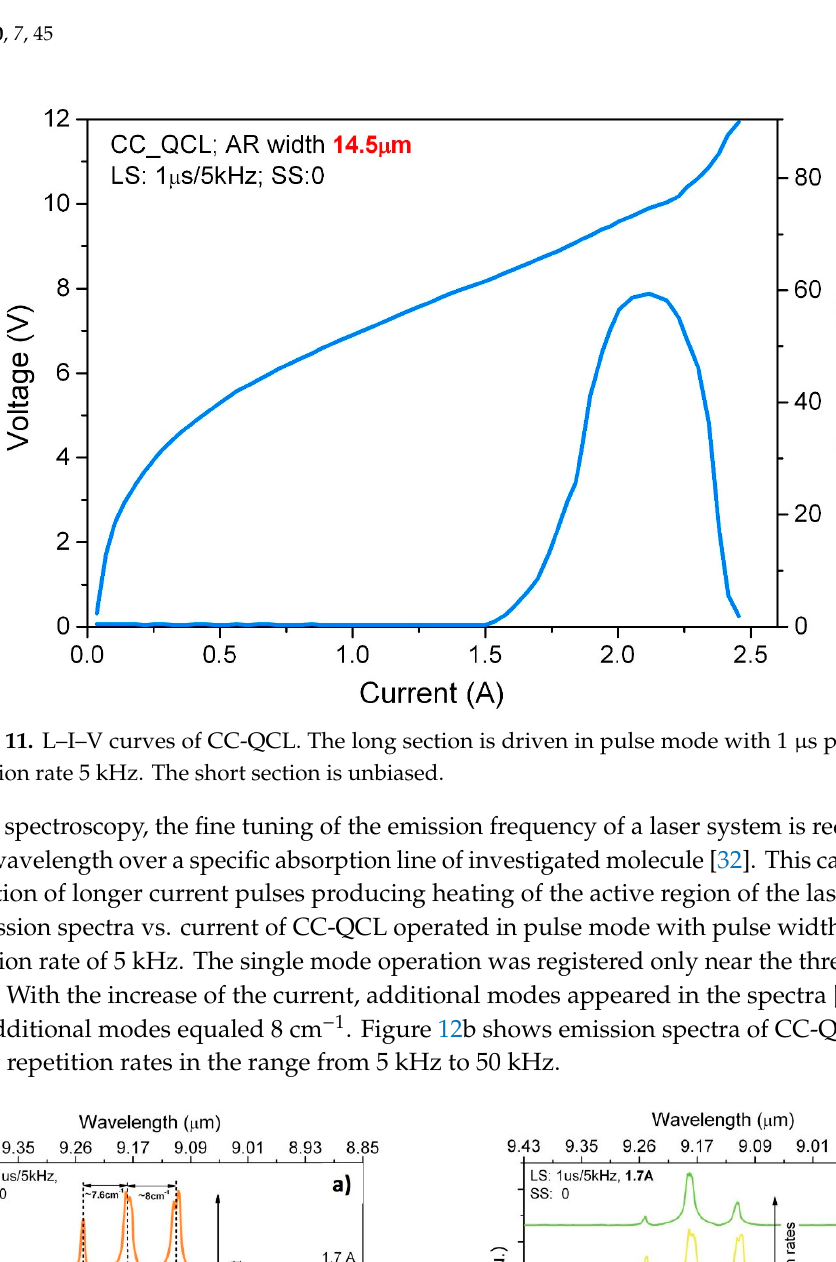
Figure 12. Emission spectra of CC-QCL registered for a set of currents starting at the threshold current of 1.5 A (6.5 kA/cm 2 ) up to 1.7 A (7.3 kA/cm 2 ) ( a ); emission spectra for CC-QCL for a set of repetition rates in the range from 5 kHz to 50 kHz ( b ). Device was operated in pulse mode with pulse width of 1 μ s. The short section was unbiased.